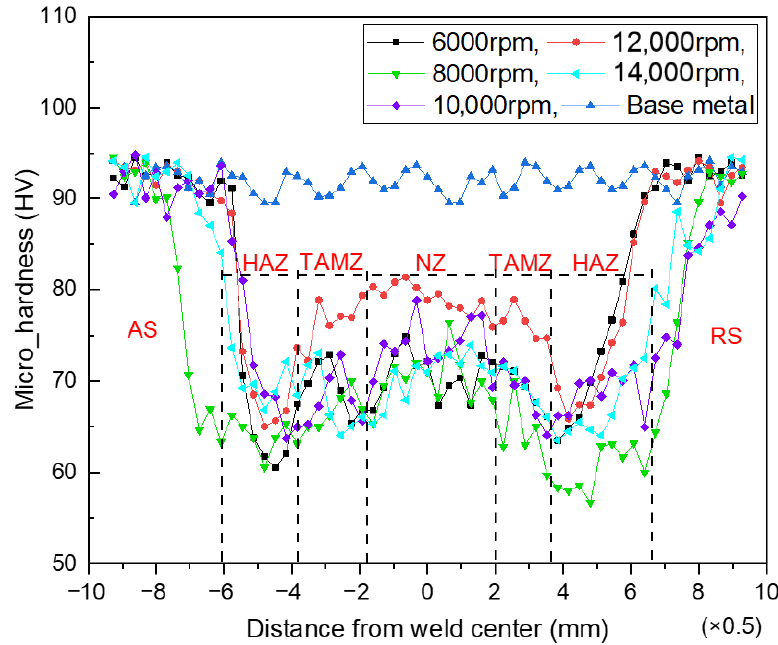
Figure 7. Variation curve of microhardness at different rotating speeds.